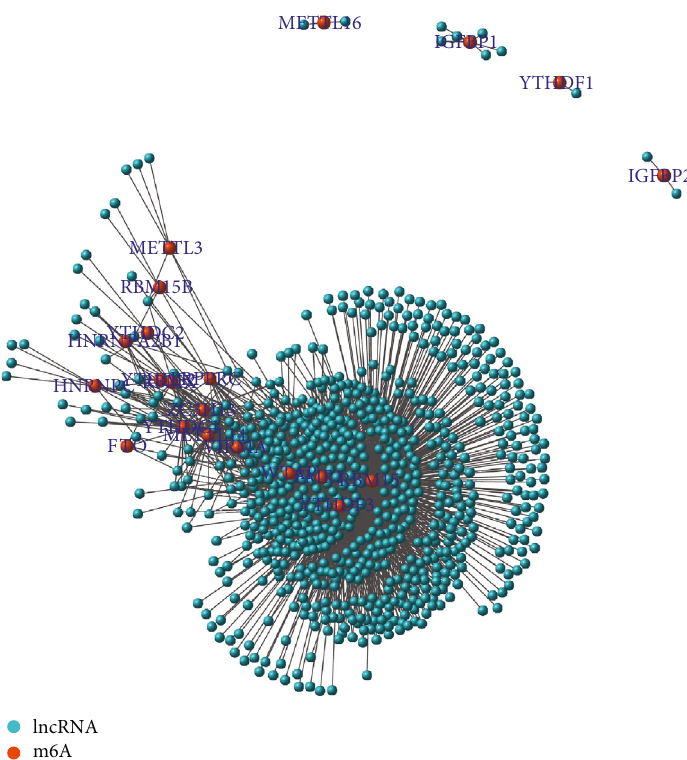
Figure 1: Network of N6-methyladenosine (m6A) as red nodes and 1080 long noncoding RNAs (lncRNAs) as blue